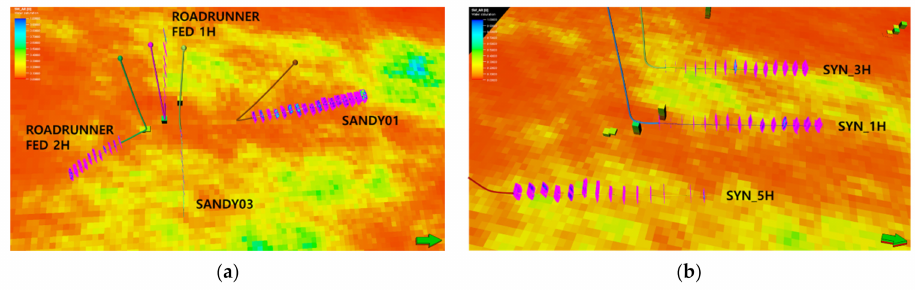
Figure 7. HFT results of ( a ) “Actual Well Pattern” and ( b ) “Proposed Well Pattern”